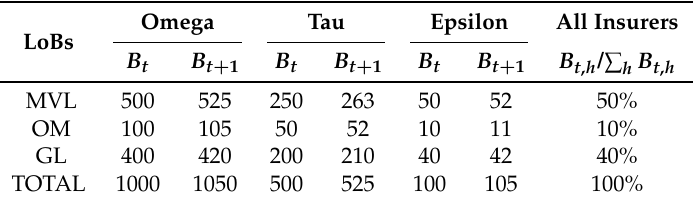
Table 8. Liabilities oriented Portfolio Mix in terms of Gross premium volumes (amounts in mln of